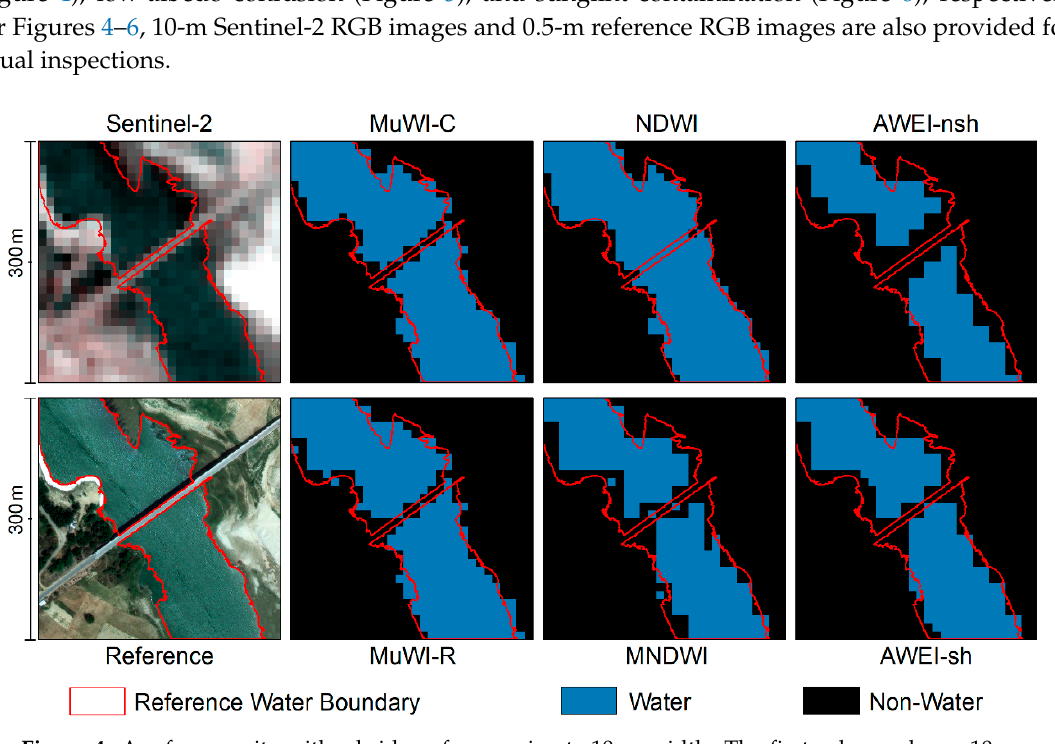
Figure 4. A reference site with a bridge of approximate 10-m width. The first column shows 10-m Sentinel-2 RGB image and 0.5-m reference RGB image. Column 2, 3, and 4 shows the water mapping results by six water index (MuWI-C, MuWI-R, NDWI, MNDWI, AWEI-nsh, AWEI-sh).